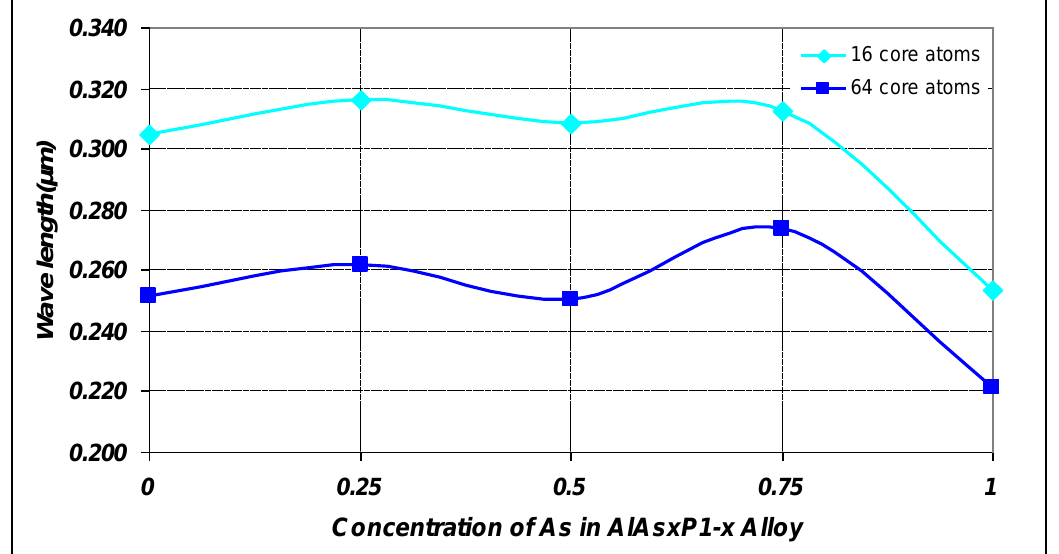
Fig.10: Variation of threshold absorption wavelength of AlAs a function of concentration of As for 16 and 64 core atoms per